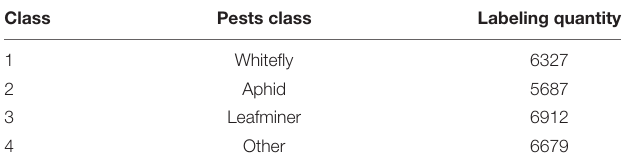
TABLE 1 | Information on tomato pest dataset.